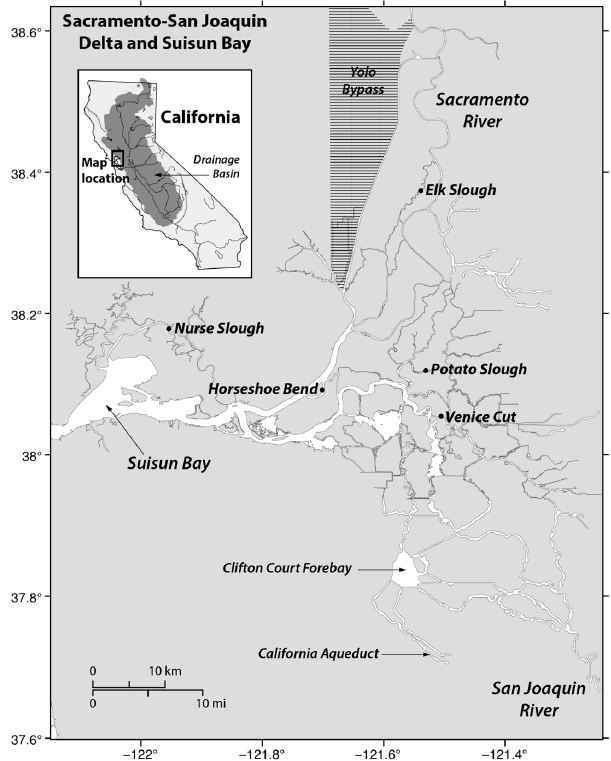
Figure 1. Map of sampling locations in the Sacramento-San Joaquin River